Question: State the chart type depicted above.
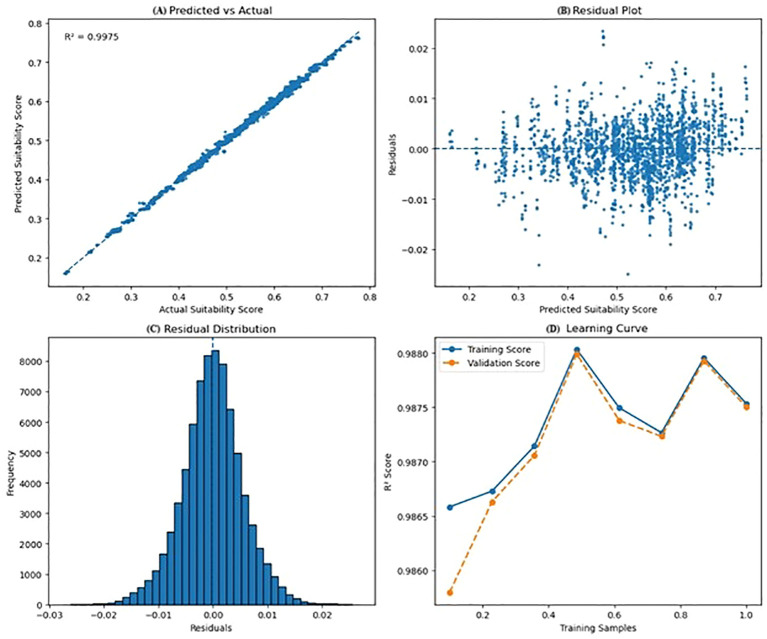
Answer: line